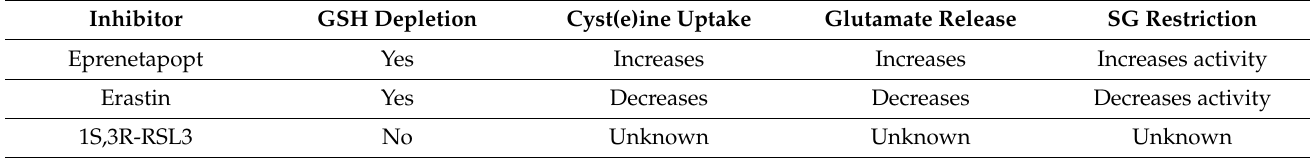
Table 1. Effect of ferroptosis inducers of GSH, cyst(e)ine uptake, glutamate release, and serine/glycine (SG) restriction. Inhibitor GSH Depletion Cyst(e)ine Uptake Glutamate Release SG Restriction Yes Increases